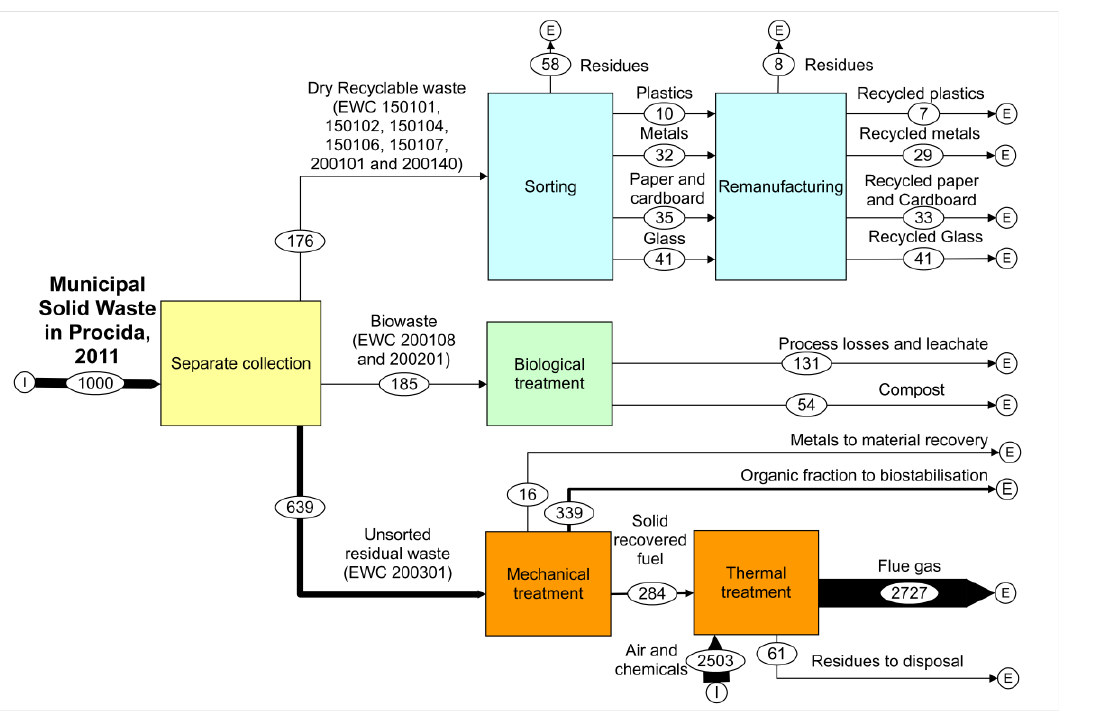
Figure 2. Quantified flow sheet of MSW management in Procida in 2011 ( top ) and 2021 ( bottom ), with reference to functional unit. Data are expressed in kg. EWC: European waste code; I: import; E: export. Data Source: W-MySir [7]. The reference composition as obtained is reported in Figure 3, starting from the com- positions of all the separately collected waste streams (as available on W-MySir) and that of URW (obtained by combining the composition of URW in input to the waste-to-energy (WtE) unit active in Campania [3], coupled with the separation efficiencies of the material recovery facility, MRF, active in the same regional area [8]). Most of data were acquired